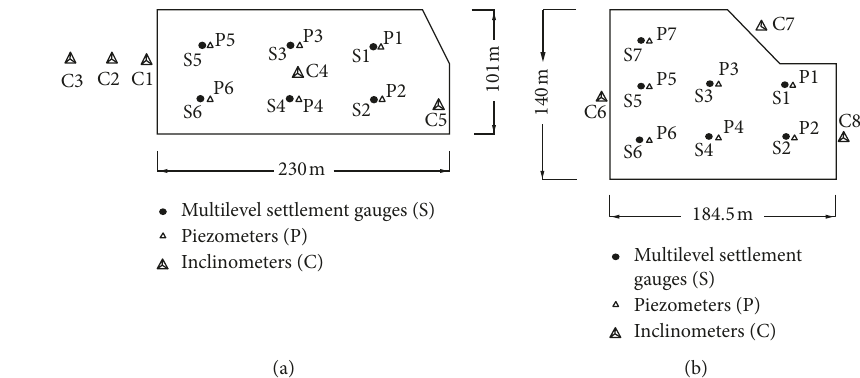
Figure 10: Plan views of the test equipment locations. (a) Section 1. (b) Section